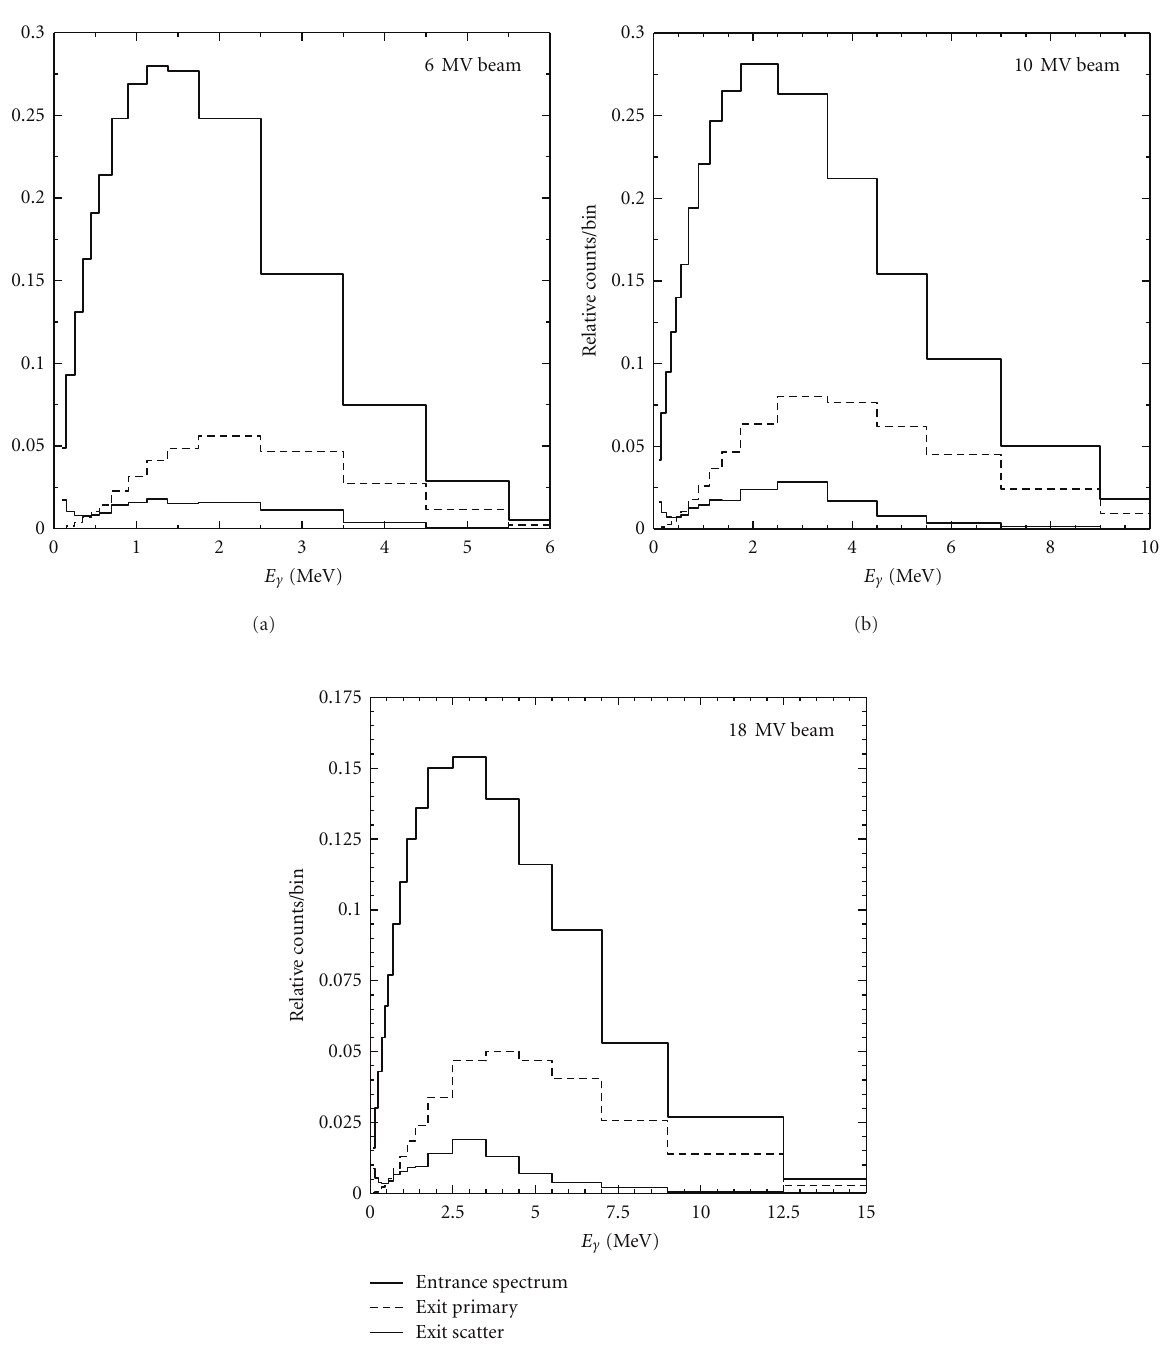
Figure 2: X-ray spectra used in the simulation. The entrance spectrum was generated by a treatment planning system (Pinnacle3, Philips), and the exit spectra of X rays were simulated by passing the incident beam (with the entrance spectrum) through a 30cm thick water